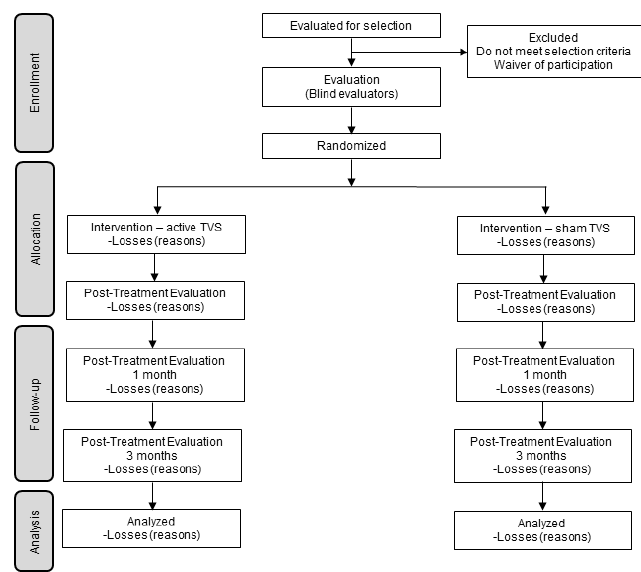
Figure 1. Progress flowchart.